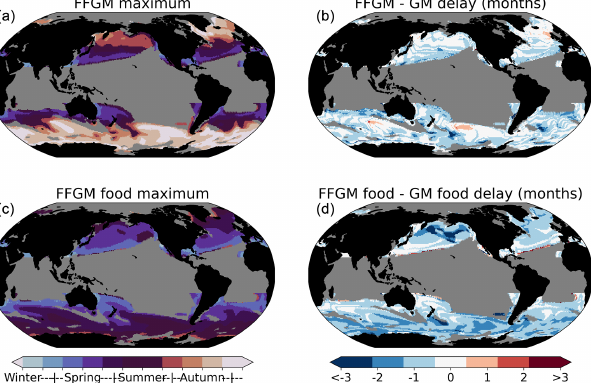
Figure A9. Spatial distribution of the annual period of maximum macrozooplankton biomasses and maximum food availability. A filter was applied to keep only the areas at more than 20 ◦ lat- itude from the Equator and in which the amplitude of annual biomass variation is higher than 20%. The amplitude is calculated as ( 2 × ( max − mix )/( min + max )) , with min being the minimum annual biomass and max being the maximum annual biomass. (a) Map of months with maximal FFGM biomasses. (b) Map of lag (in months) between months of maximal FFGM biomasses and months of maximal FFGM biomasses. (c) Map of months with maximal FFGM food availability (calculated as the sum of prey weighted by FFGM preferences for each prey). (d) Map of lag (in months) be- tween months with maximal FFGM food availability and months with maximal GM food